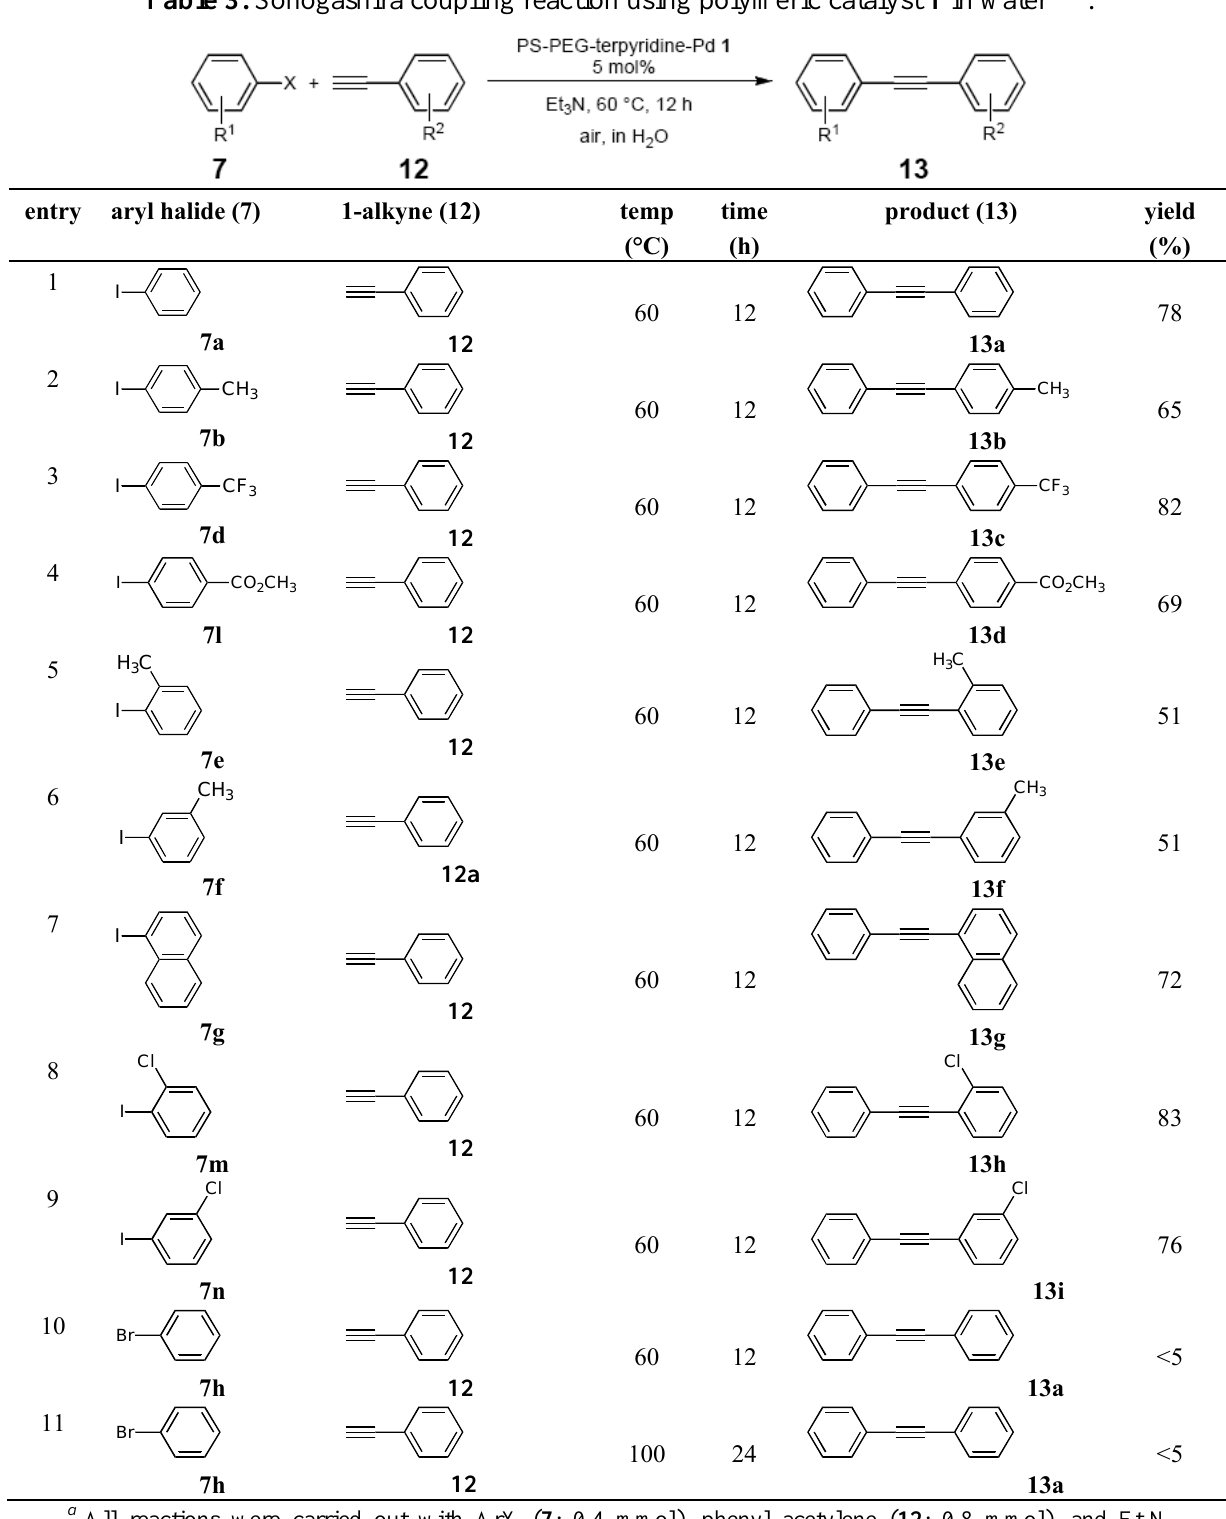
Table 3. Sonogashira coupling reaction using polymeric catalyst 1 in water a, b